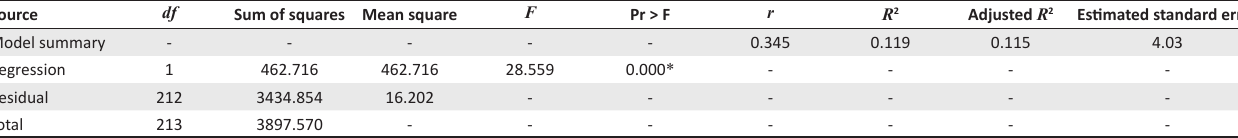
TABLE 1: Simple linear regression model fit and summary for work resources on employee mental health. Source df Sum of squares Mean